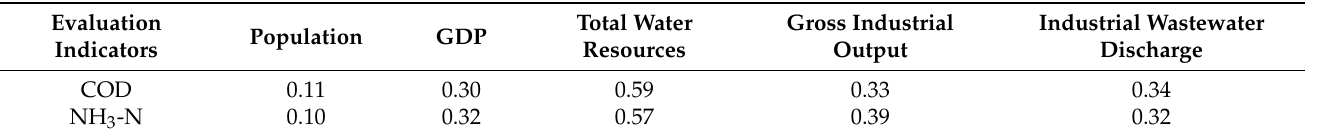
Table 2. Gini coefficient of corresponding pollutants under each evaluation index in Anhui Province in 2015.